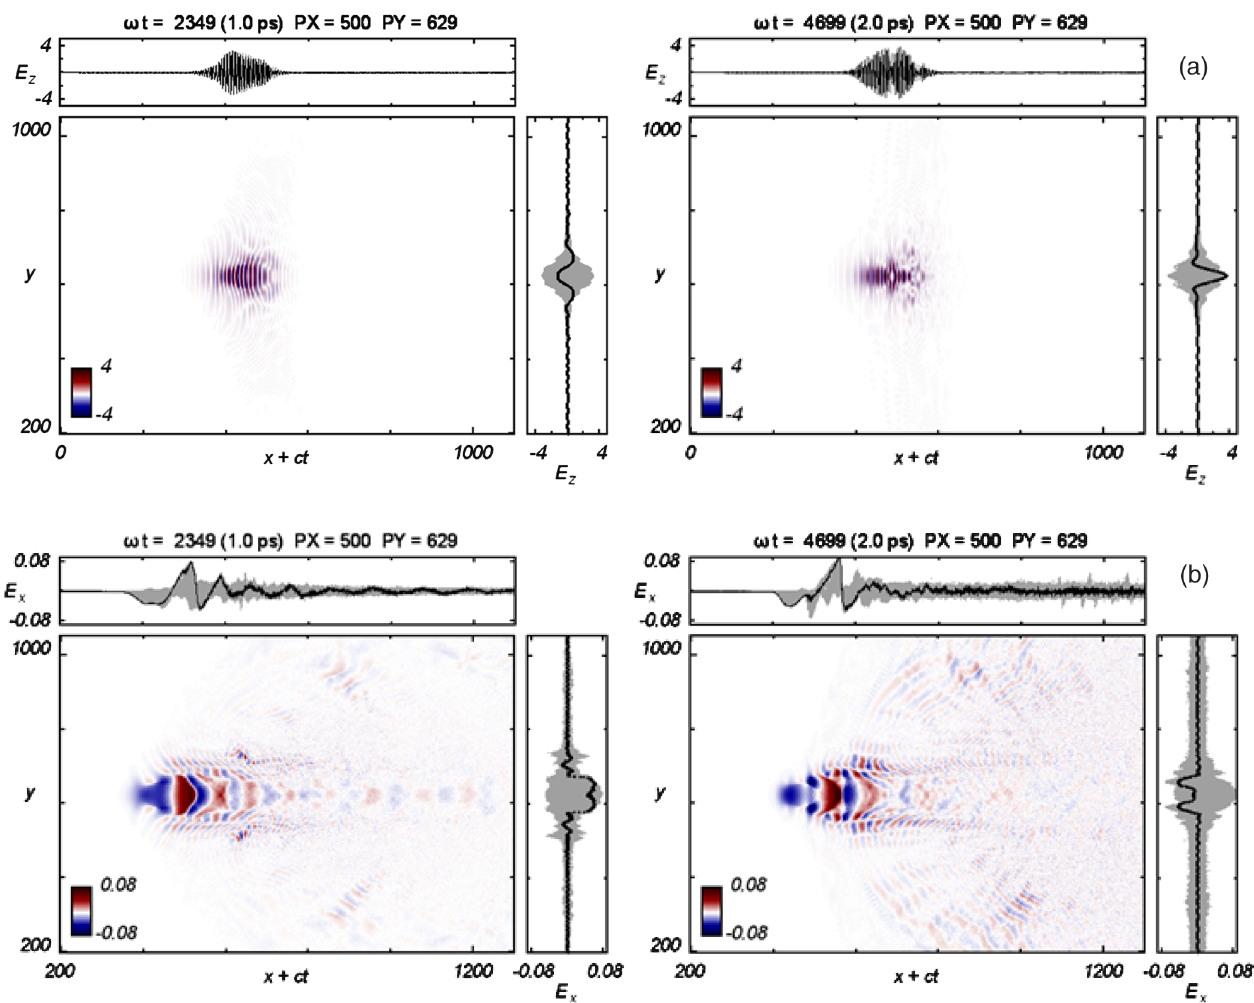
FIG. 15. Calculated laser and plasma field distributions: (a) Laser field distribution at different times, (b) Plasma field distributions at different